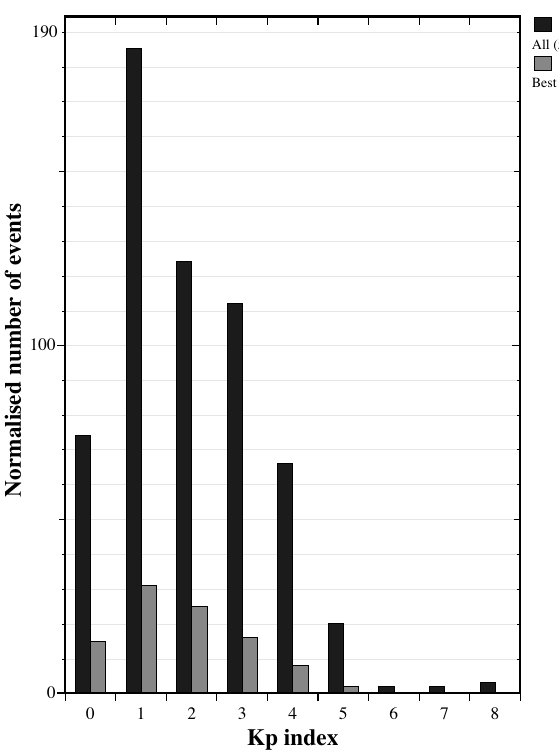
Fig. 8. Cross-polar cap potential measured at the times of the inverted-V observations show that the polar cap potential (Y-axis) is always at least three times larger (solid line) than the peak energy of the inverted-V (X-axis).